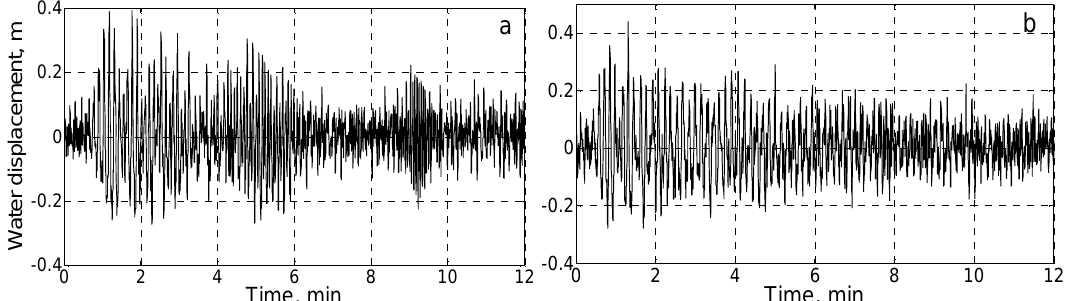
Fig. 3. Vessel wakes from a) “SuperStar” (18 June 2009, 16:15), b) “Star” (20 June 2009, 12:10).